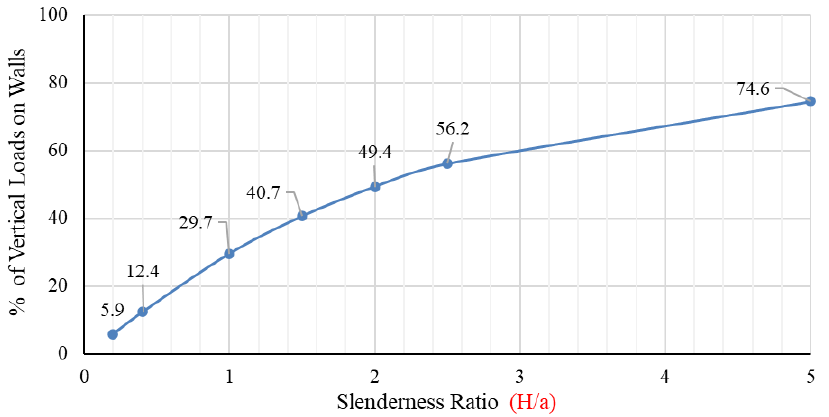
Figure 14. Percentage of vertical load distribution on rigid walls for different slenderness ratios.